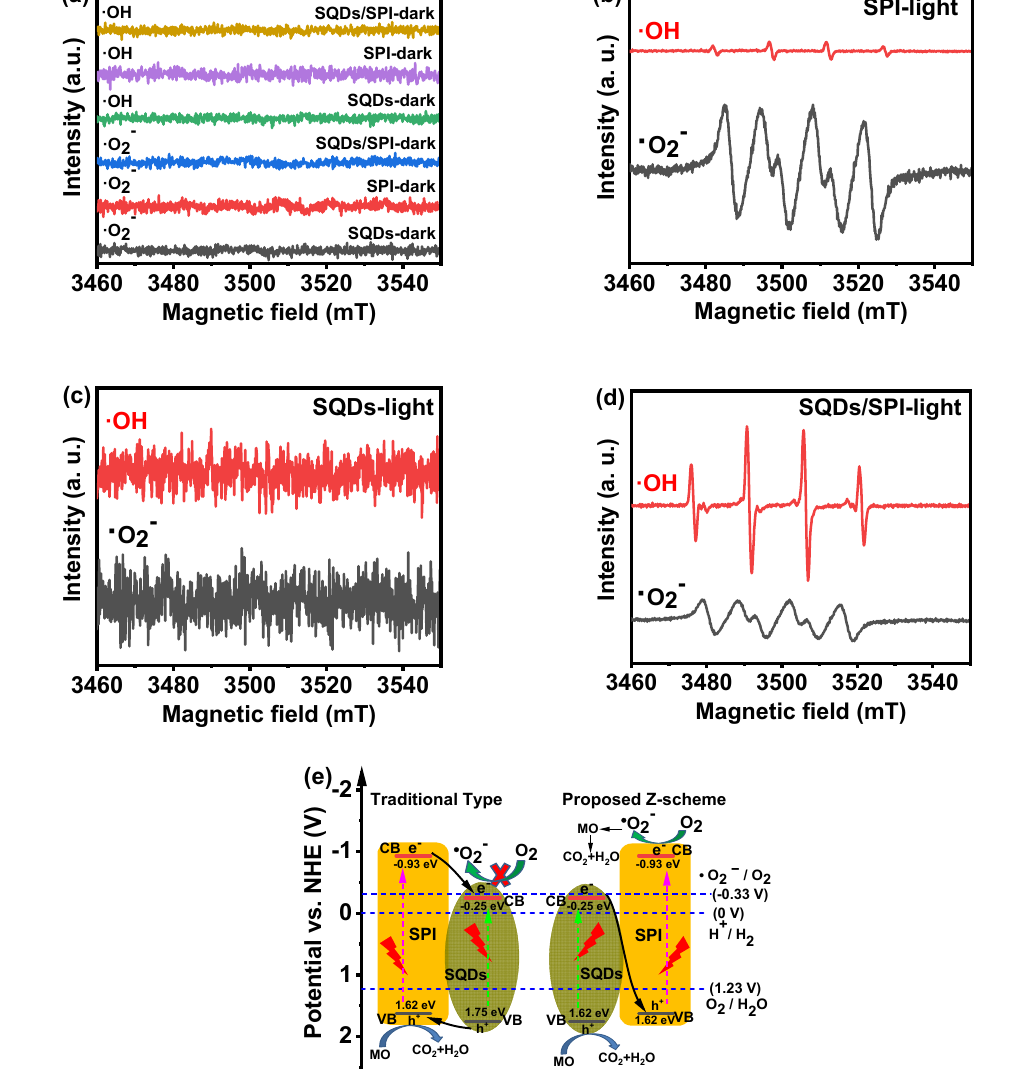
Figure 10. ESR spin-trapping spectra of ( a ) SQDs, SPI, and SQDs/SPI samples in dark. DMPO spin-trapping ESR spectra of ( b ) SPI, ( c ) SQDs, and ( d ) 10SQDs/SPI samples under light irradiation. ( e ) the proposed photogenerated charge carrier’s separation and transfer mechanism in the SQDs/SPI